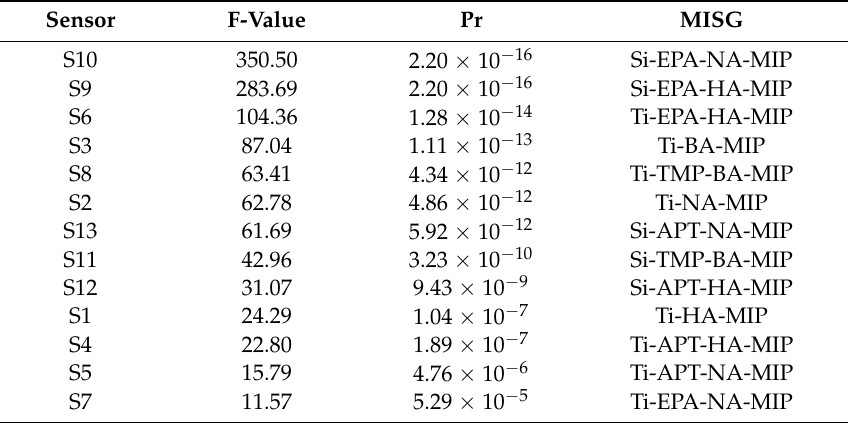
Table 2. F values calculated by MANCOVA for 13 sensor